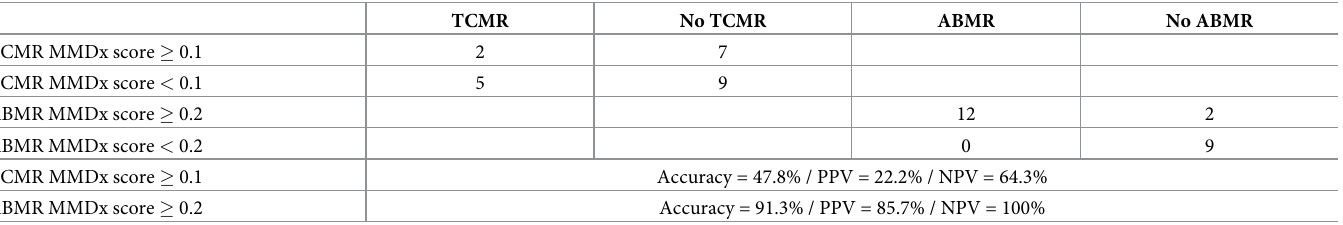
Table 7. Agreement of histologic diagnosis with molecular